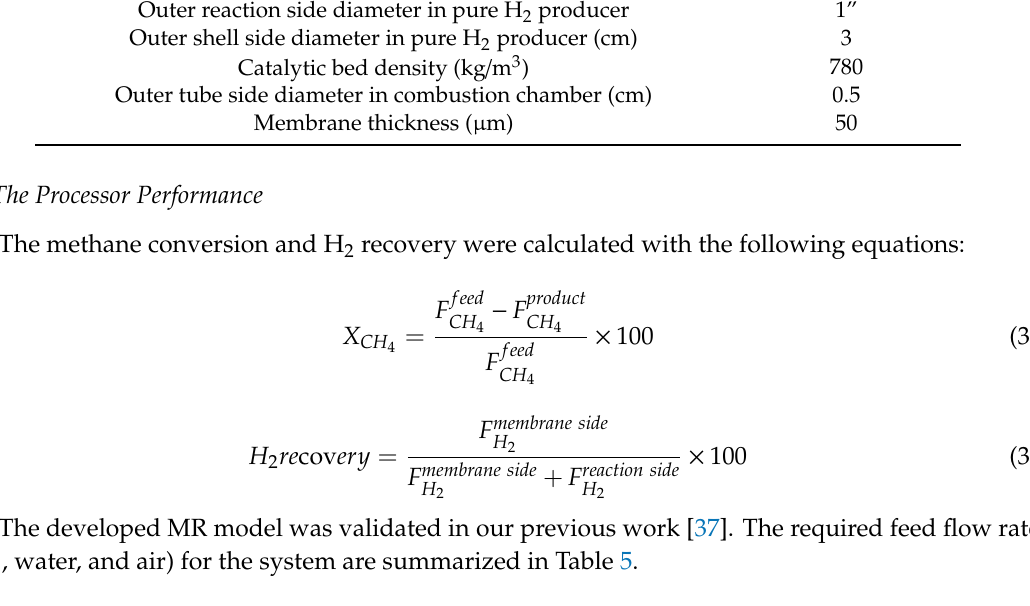
Table 5. Feed flow rates for the proposed on-board